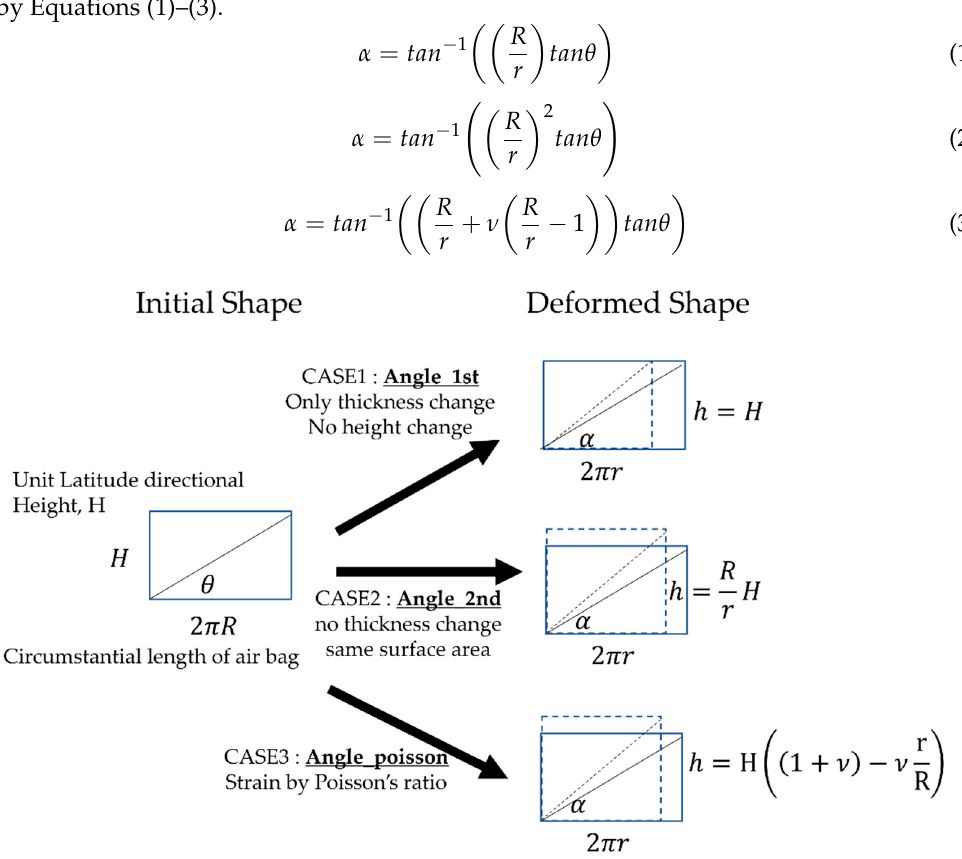
Figure 2. Conceptual diagram of angle prediction equations.